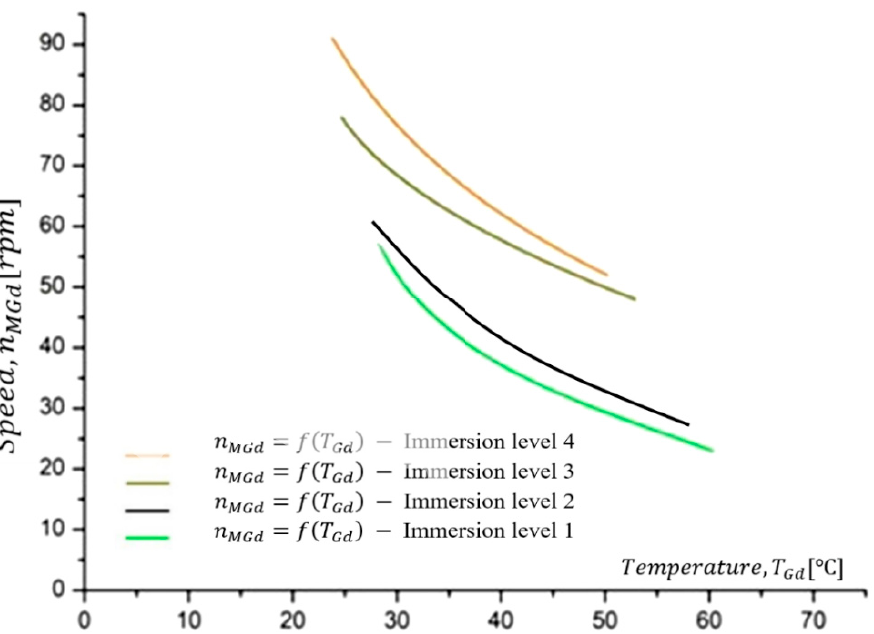
Figure 9. Speed variation in motor due to change in the number of gadolinium tablets immersed in the considered volume of water.